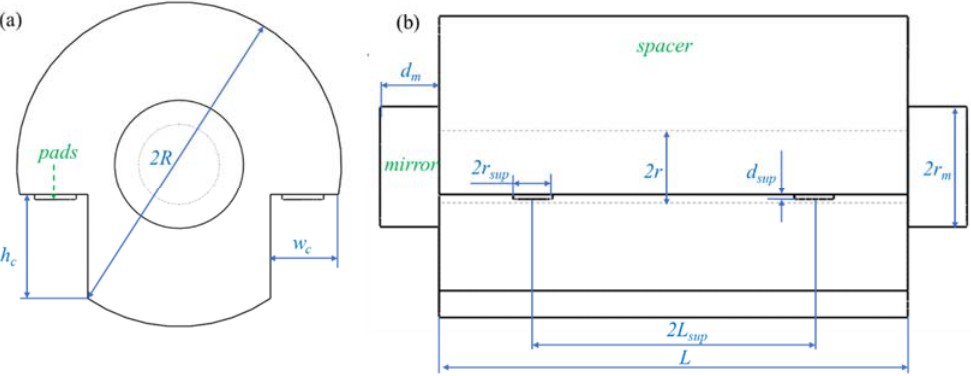
Figure 1. Geometrical model of the cylindrical USC supported by four elastic support pads. ( a ) Front view. ( b ) Side view.